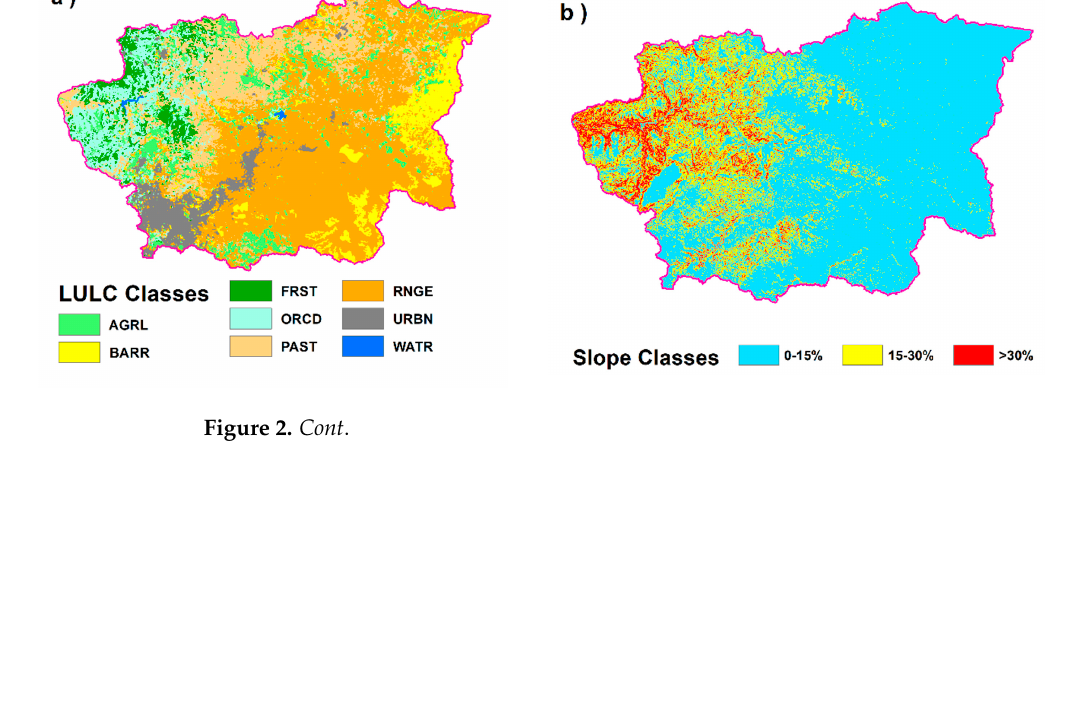
Figure 2. GIS ‐ based parameters used in SWAT modeling, a) Land use/Land cover (LULC) classes, b) Slope Classes, c) Soil classes and d) Main streams and climate stations. 2.2. SWAT Modeling ArcSWAT version 2012_10_3.19 interface for ArcGIS 10.1 was used to simulate the historical and future projected water hydrology of the AZB. Three spatial input datasets were prepared for SWAT modeling, including the Digital Elevation Model, Land use/Land cover, and soil. Varied information database files for different aspects of the watershed climate and hydrology, including lookup tables, gauging station’s location, and daily weather data, were provided [9,12]. Table 1 summarizes the different data sets used in this study to develop the SWAT model. Table 1. Data sets used to develop SWAT Model. Data Set